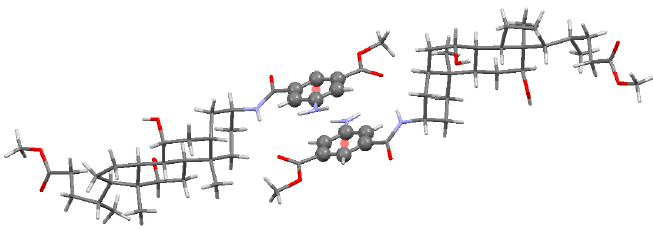
Figure 5. View of the crystal packing of compound 24 along a direction in which the π - π interaction is clearly seen. The red points correspond to the centroids of the involved aromatic rings.